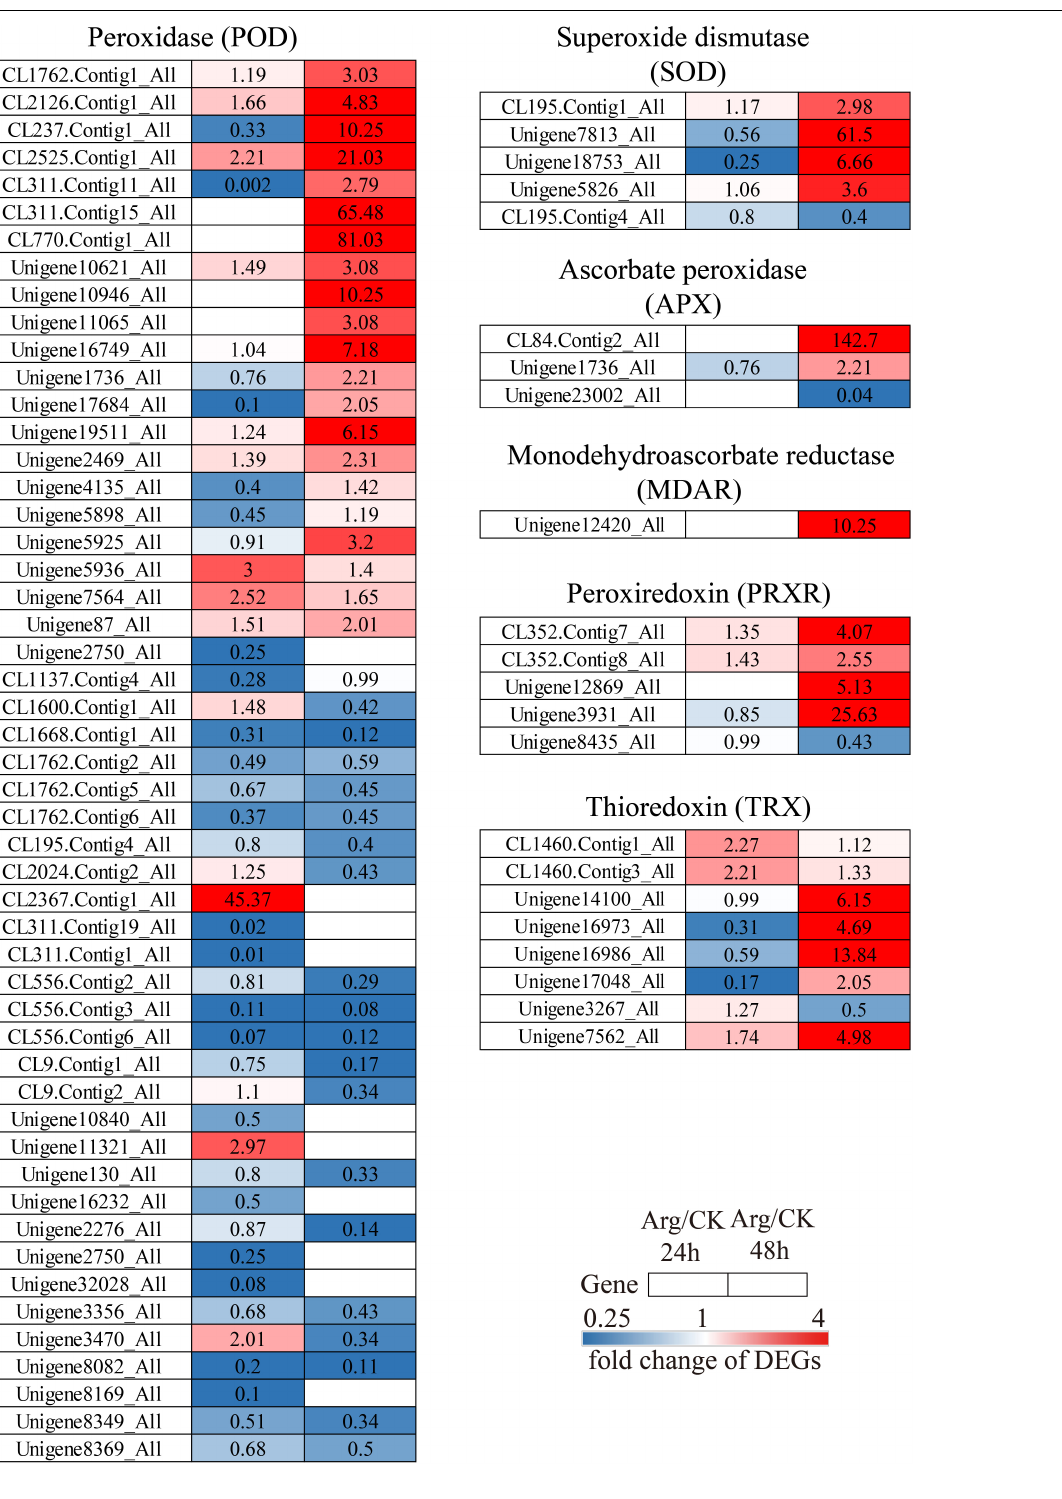
Frontiers in Marine Science |